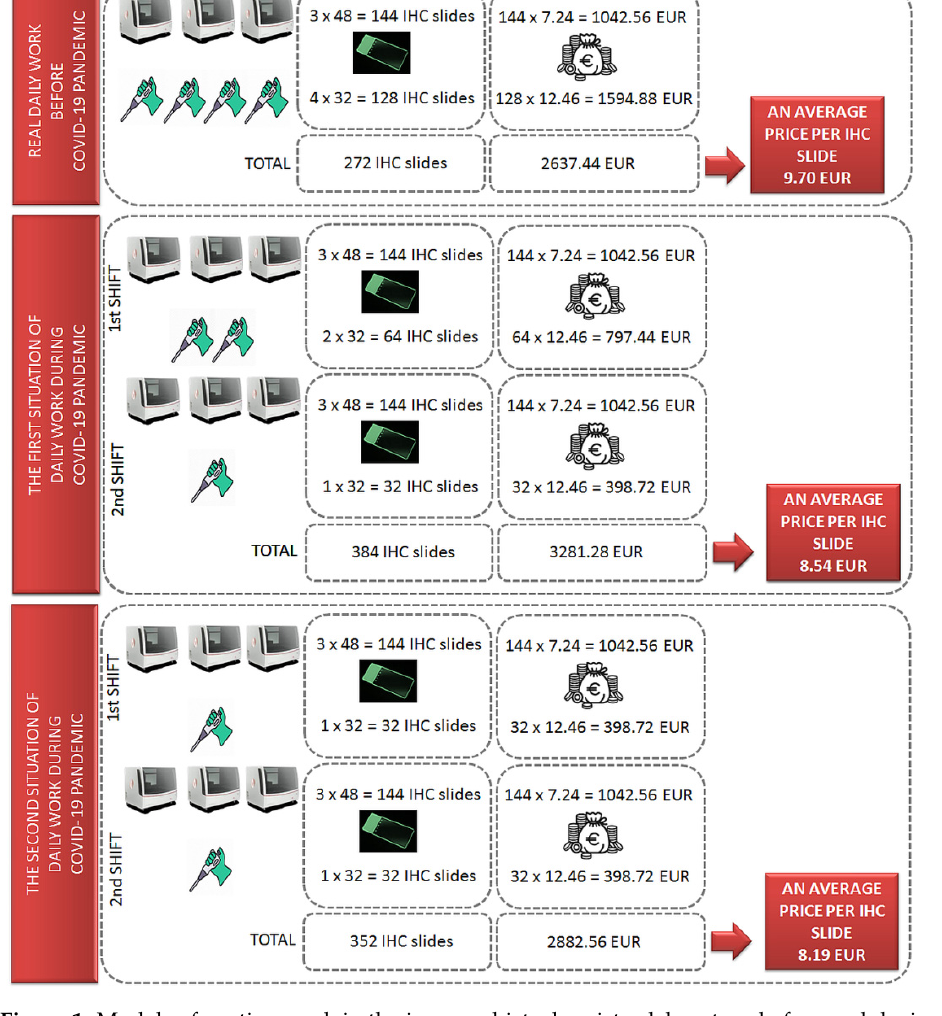
Figure 1. Models of routine work in the immunohistochemistry laboratory before and during the COVID-19 pandemic.